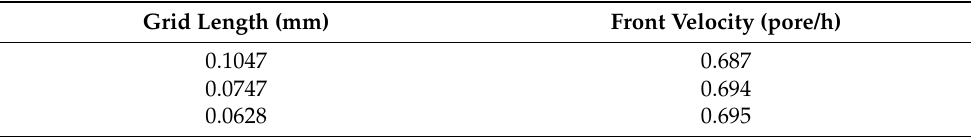
Table 3. Grid sensitivity